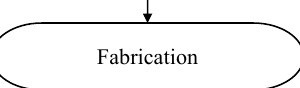
Figure 8. An example of search results by DL query.